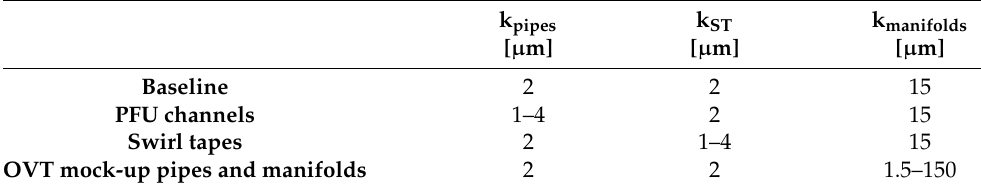
Table 11. Absolute Hydraulic Wall Roughness values investigated.